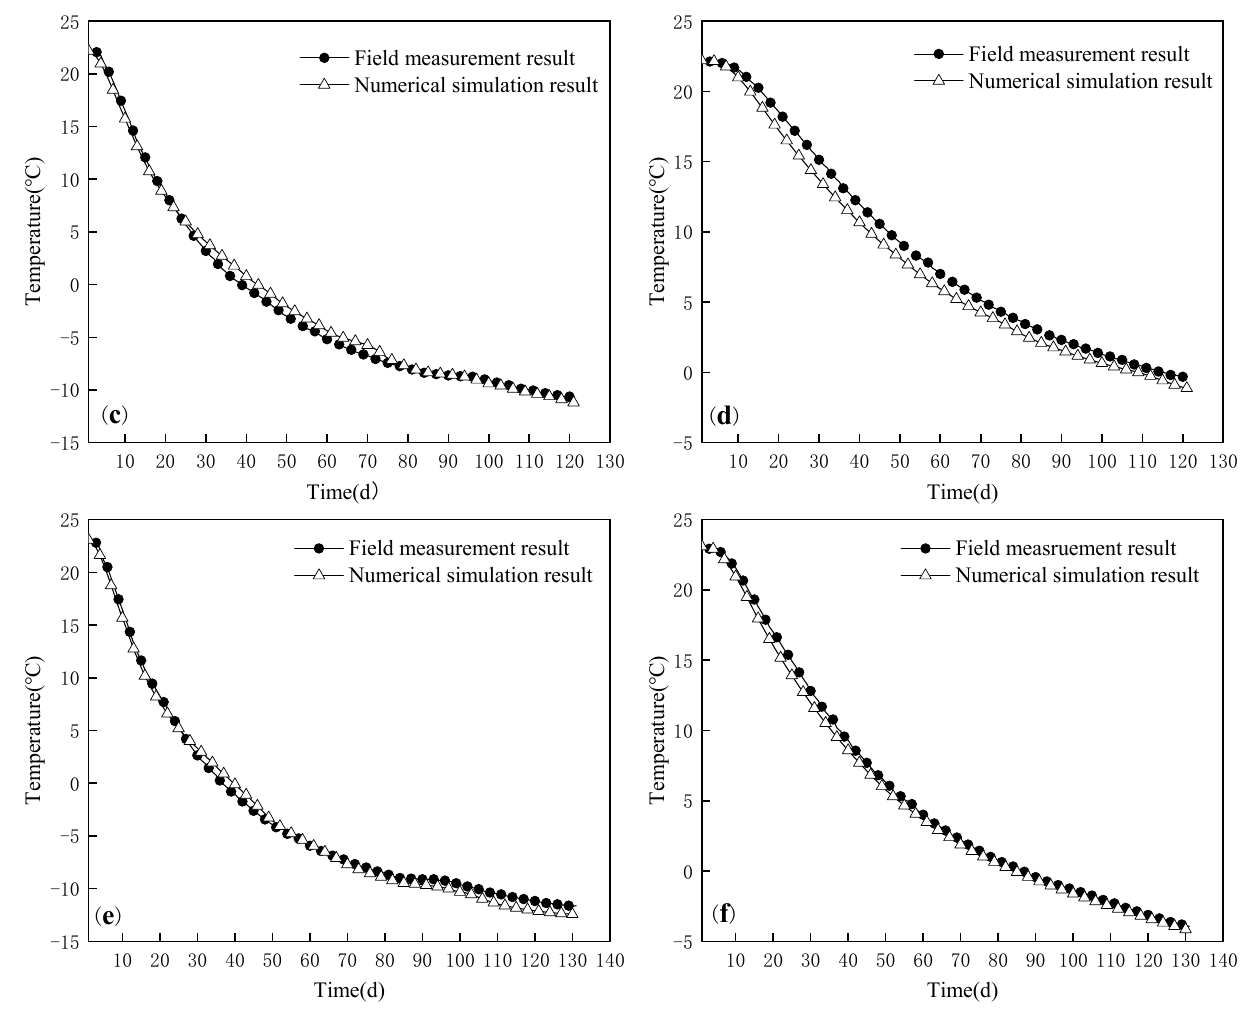
Figure 4. Comparison between simulated and measured results at different layers. ( a ) C1 measurement point of − 120.5 m fine sand. ( b ) C3 measurement point of − 120.5 m fi ne sand. ( c ) C1 measurement point of − 190 m clay. ( d ) C2 measurement point of − 190 m clay. ( e ) C1 measurement point of − 216 m sandy clay. ( f ) C2 measurement point of − 216 m sandy clay.